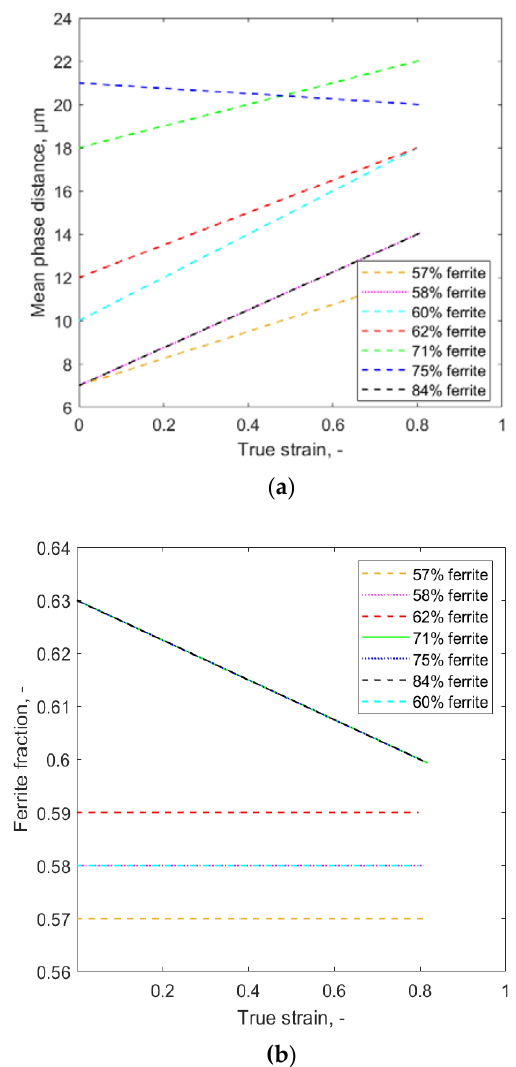
Figure 7. ( a ) Linearly interpolated mean phase distances for the investigated material conditions used as inputs for the duplex model ( b ) Linearly interpolated ferrite fractions for the investigated material conditions used as inputs for the duplex model.